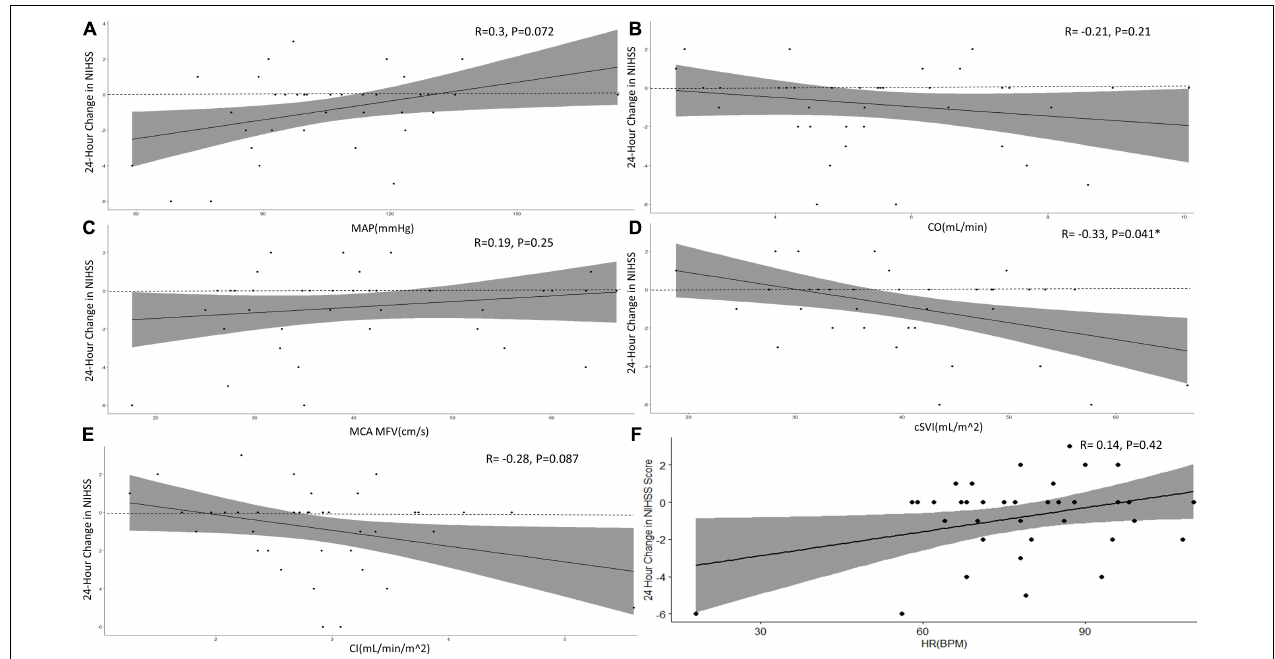
FIGURE 1 | Correlations between hemodynamic measurements with 24-h change in NIHSS score. Figure shows Spearman-Rank correlations between hemodynamic parameters, (A) MAP, (B) CO, (C) MFV, (D) cSVI, and (E) CI with total 24-h NIHSS score change from baseline (dashed line). Line graphs are shown with error shaded in and respective R - and P -values. ∗ P < 0.05.